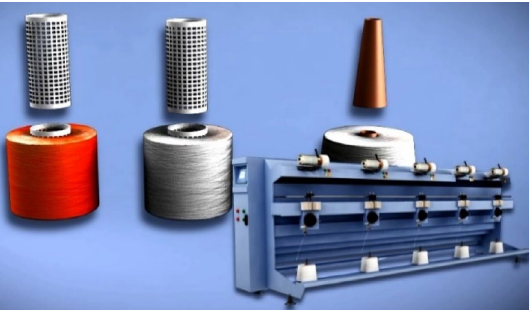
Figure 4. Raw material paper verse plastic cones, and soft winding machine [Courtesy of EL Sharq El Awsat Co.].